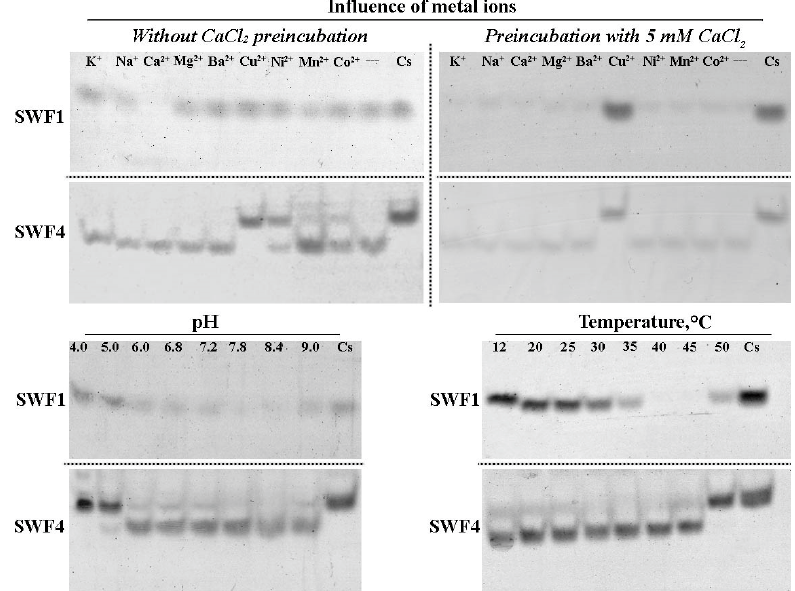
Figure 4. The electropherogram of the action of sulfatases SWF1 and SWF4 on oligosaccharides 4F2,3S(6S) (for SWF4) and 4F2S(4S) (for SWF1) at different temperatures; the presence of buffers with